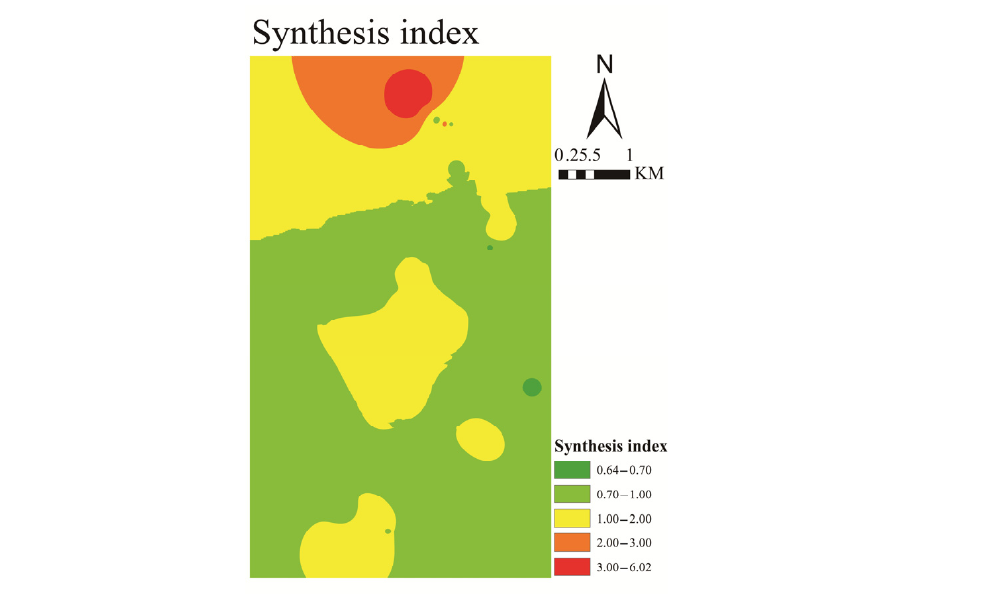
Table S3: pH and concentrations of soil samples, Table S4: The EF index values, Table S5: The geoaccumulation index (I geo